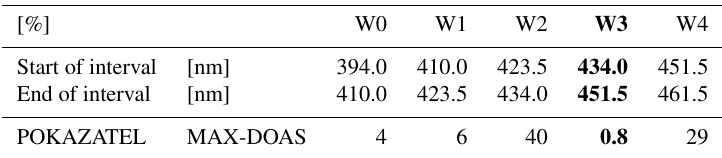
Table 8. Typical relative DOAS fit errors in fitting windows W0–W4 at a water vapour dSCD in W3 of 4 × 10 23 moleccm − 2 for an individual spectrum integrated over 60s. Values are given in % and are corrected by the relative magnitudes given in Table